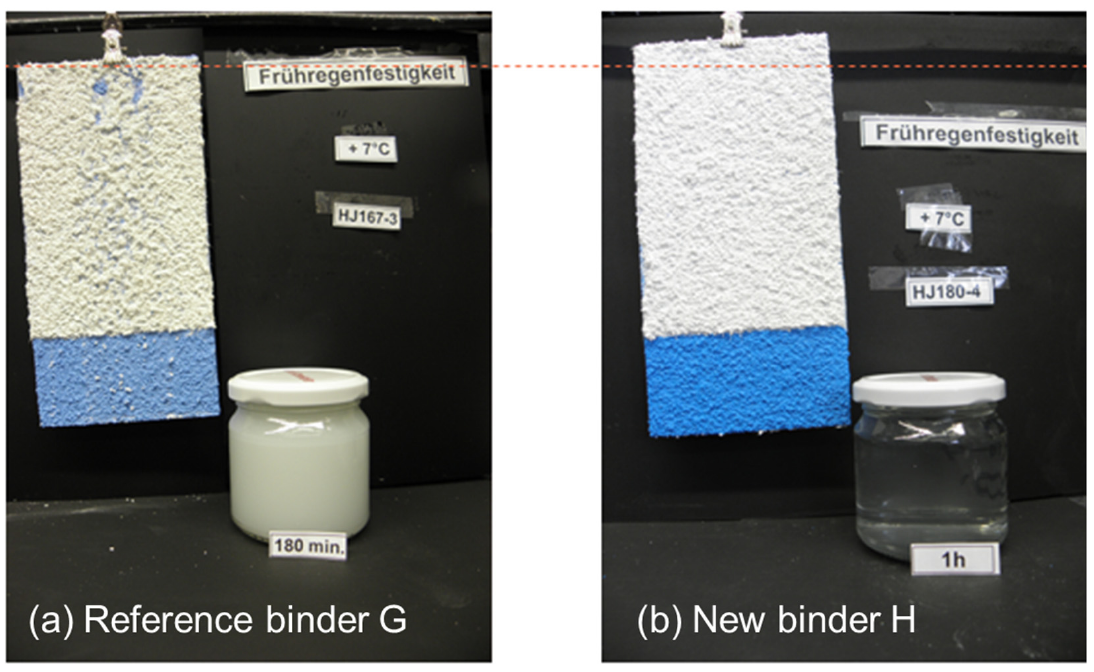
Figure 12. ERR tests of white render topcoats, formulated according to Table A4 in Appendix A and applied and tested according to Section 2.2. Red line marks the highest spot with water exposure.